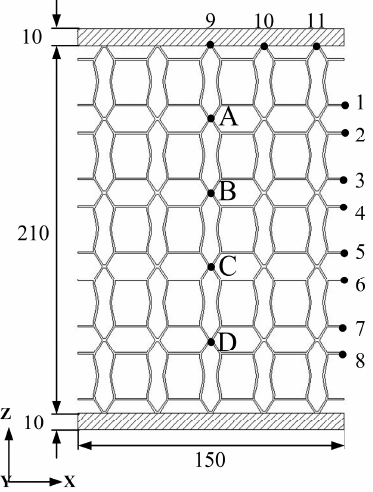
Figure 5. Metamaterials and the location of measuring points with 𝜈 = +1.0 (unit: mm).